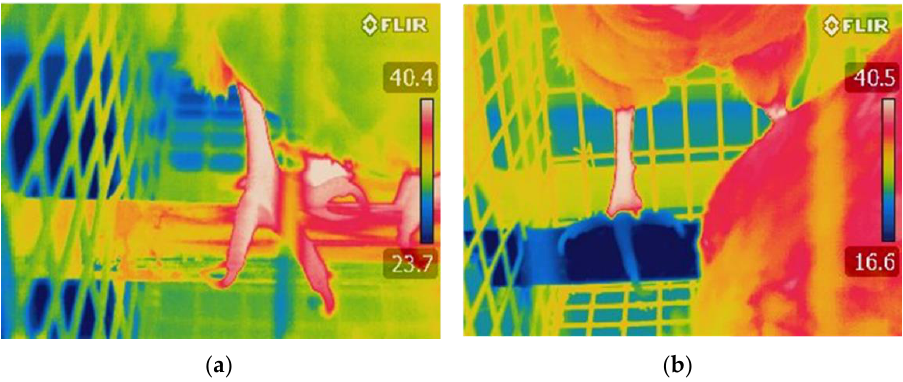
Figure 3. Examples of infrared thermal images (FLIR T440, FLIR Systems, Inc.; the camera was set at an emissivity of 0.95) of the feet temperature of hens standing on: ( a ) an air perch; and ( b ) a cooled perch. Notes: Compared to air perch hens, cooled perch hens had much colder feet.